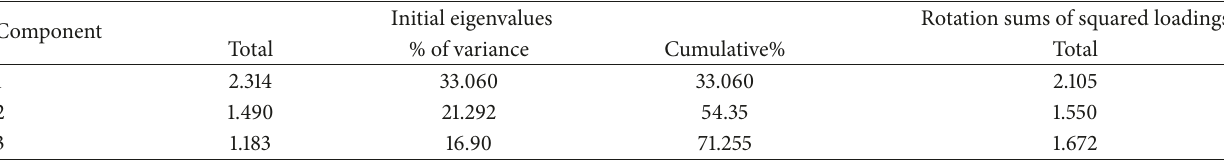
Table 4: Factor analysis attitude domain: construct validity.